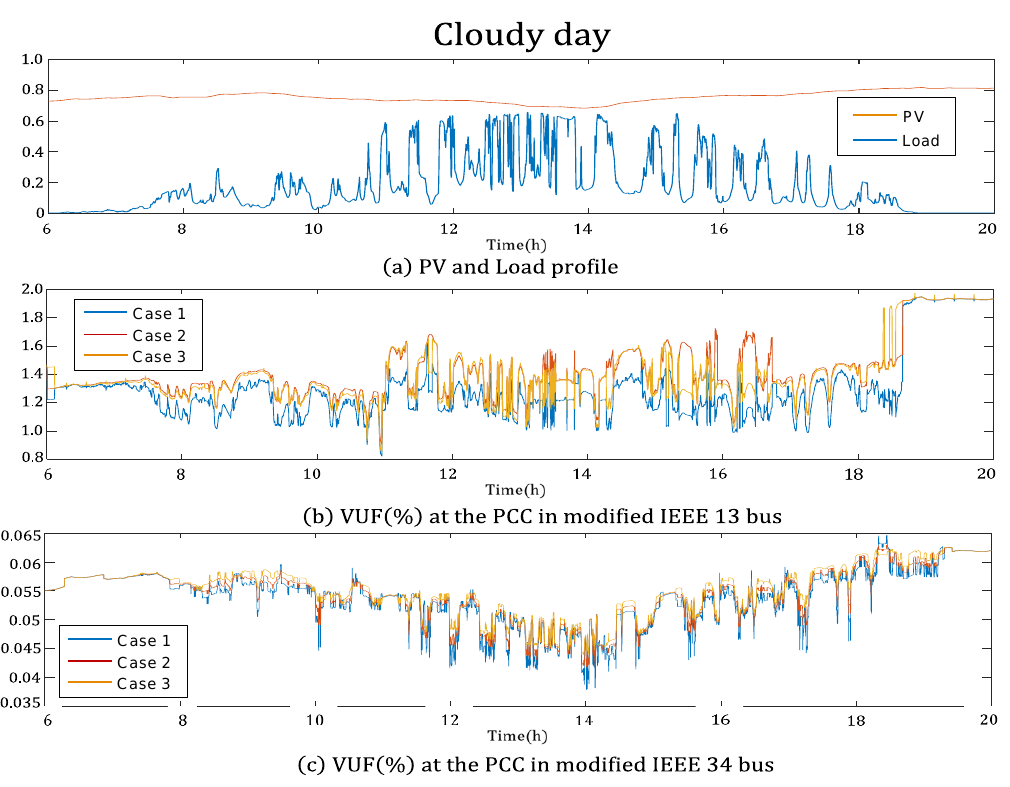
Figure 11. PV and load profile and 𝑉𝑈𝐹(%) at the PCC for a cloudy day.